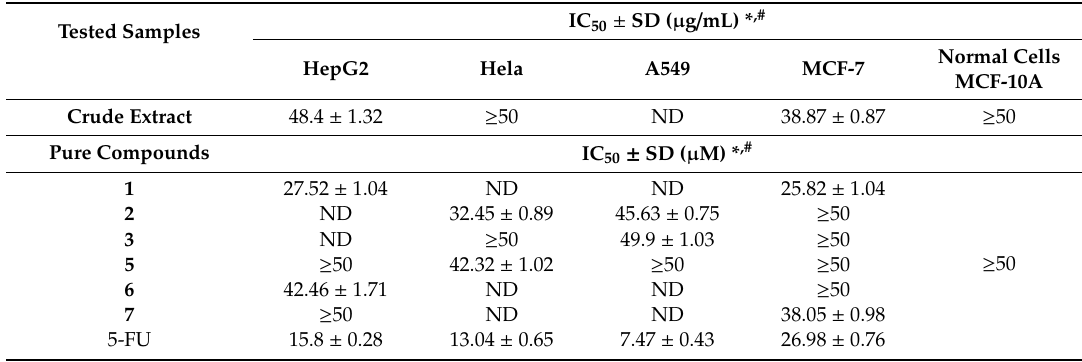
Table 2. Summarized IC 50 of crude and identified sterol derivatives against four cancerous cell lines: HepG2, Hela, A549, and MCF-7 and normal cells.